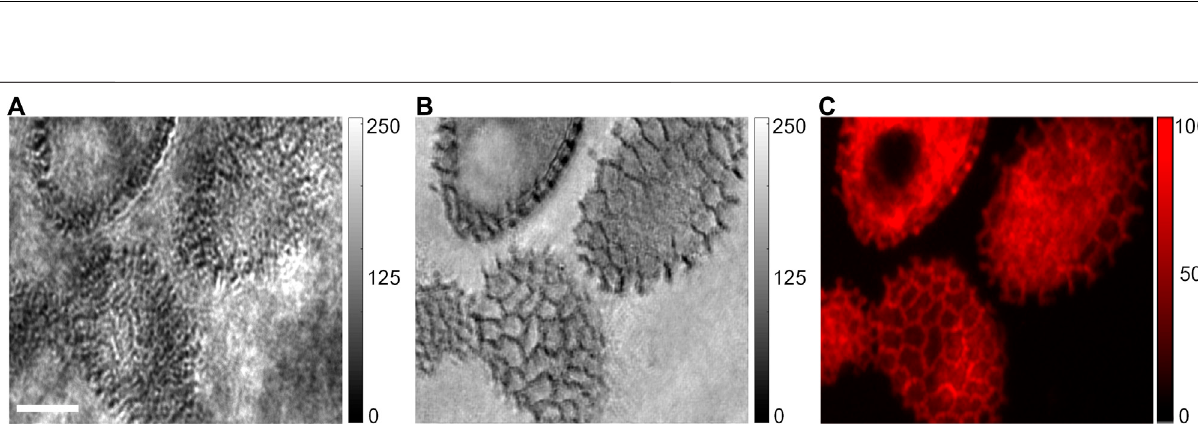
Frontiers in Physics |